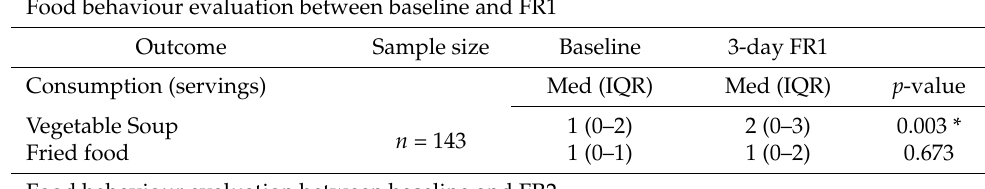
Table 3. Comparison of outcomes between baseline and post-intervention 3-day food records (FR1, FR2, FR4, FR5 and